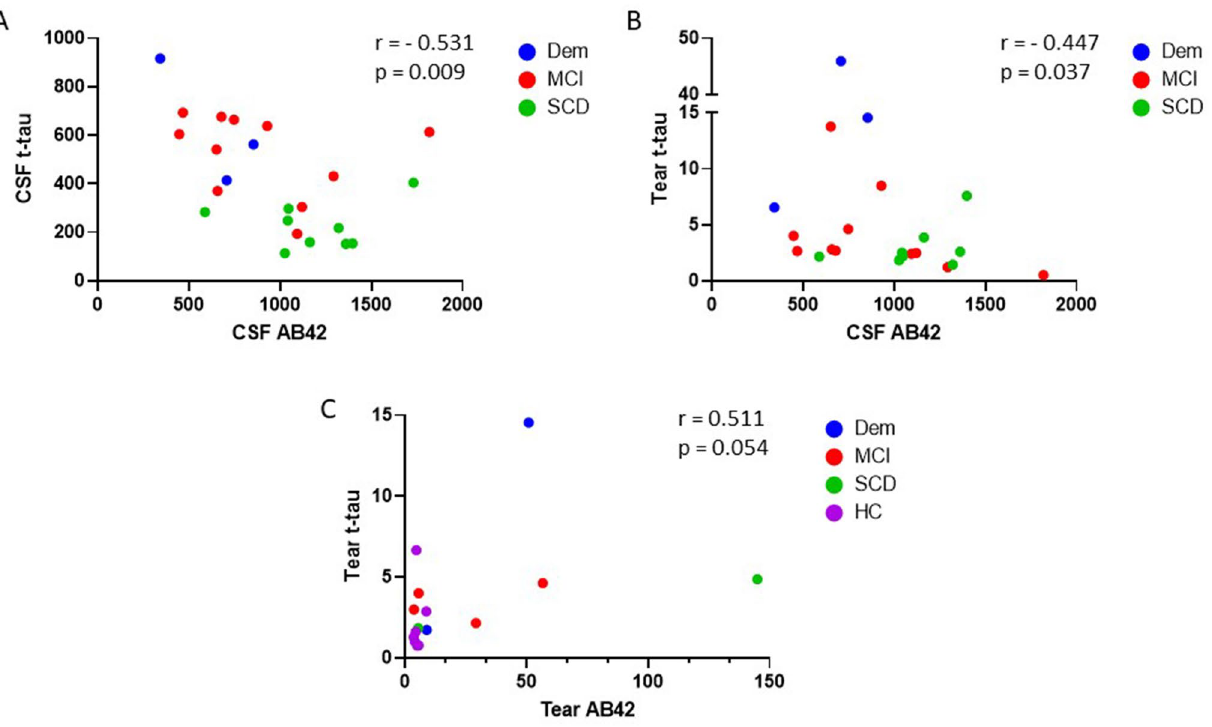
Figure 3. Correlation matrix between t-tau and AB42. Correlation between t-tau and AB42 for (A) CSF, (B) tear and CSF and (C) tear. Results are presented as Spearman rank correlation coefficients (r) and p-values